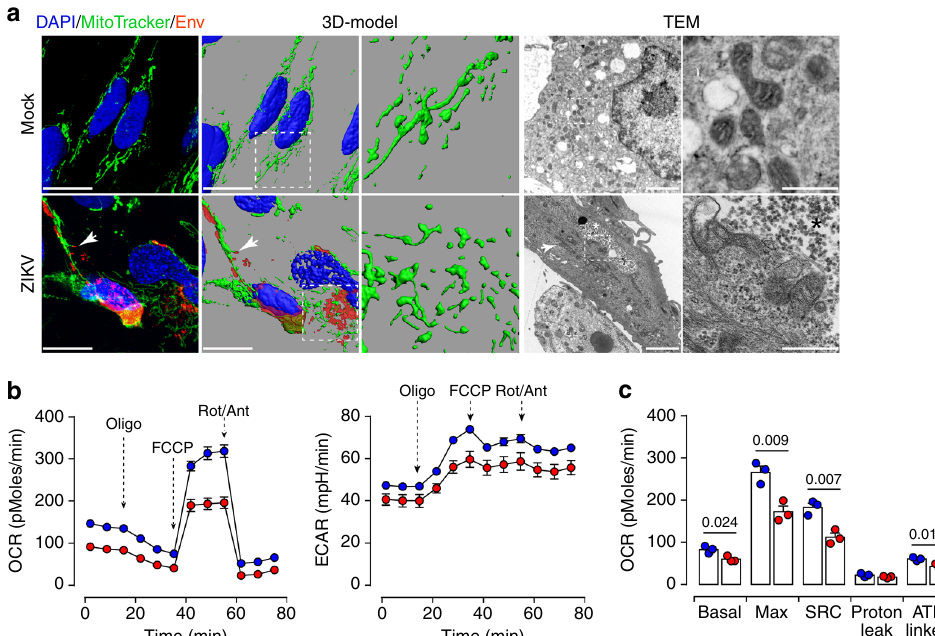
Fig. 8 ZIKV infection impairs mitochondrial network distribution and respiratory capacities. a Z-stack projection of confocal images from mock- and ZIKV-infected placental cells are stained with MitoTracker Deep Red FM (green) and anti-Flavivirus group antigen antibodies (Env, red). Nuclei are stained with DAPI (blue). 3D-view models are reconstructed by Imaris software. Scale bar, 20 μ m. TEM micrographs showing the distribution in mock- and ZIKV- infected cells. Elongated size mitochondria are found in ZIKV-infected cells (white arrow). Scale bar, 2 μ m. The white rectangle denotes the enlarged region shown in right magni fi cation panels. Clustered viral particles (*) are found in close proximity with abnormal mitochondria. Scale bar, 500 nm. b OCR measured in mock- and ZIKV-infected placental cells by Seahorse XFp analyzer. c Bar graphs comparing OCR parameters: basal, maximal and spare respiratory capacities (SRC), and ATP-linked OCR. Data are presented as mean values ± SEM from three independent donors. P values are computed using two-tailed Student ’ s t test. Source data are provided as a Source Data fi le.